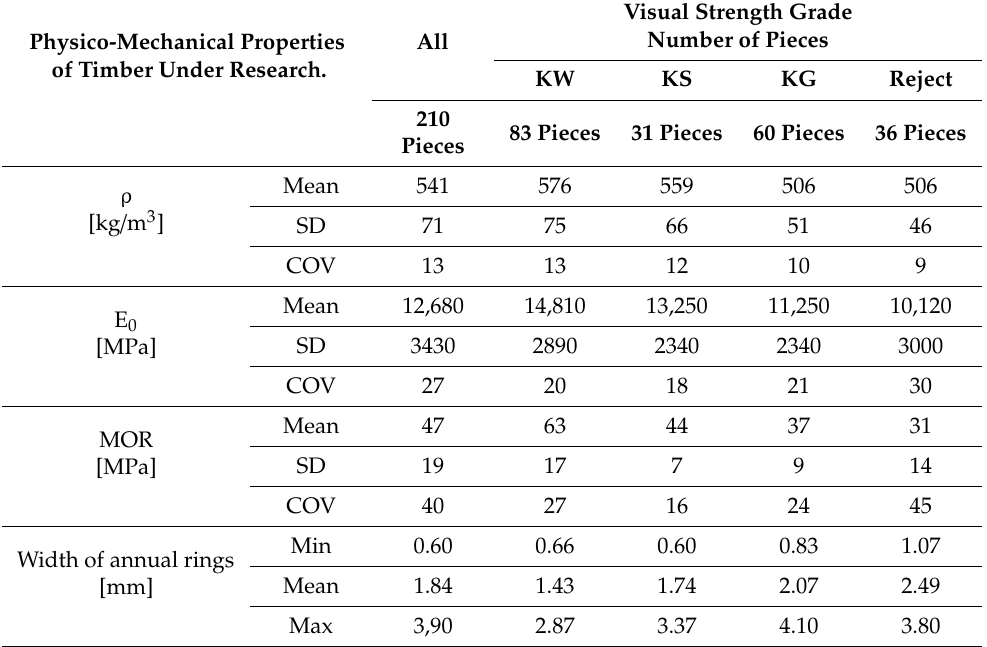
Table 2. Corrected (in line with EN 384) average values of: density ( ρ ), modulus of elasticity parallel to the grain (E 0 ), static bending strength (MOR), and width of the annual rings of the timber under research. Visual Strength Grade Number of All Physico-Mechanical Properties of Timber Under Research.